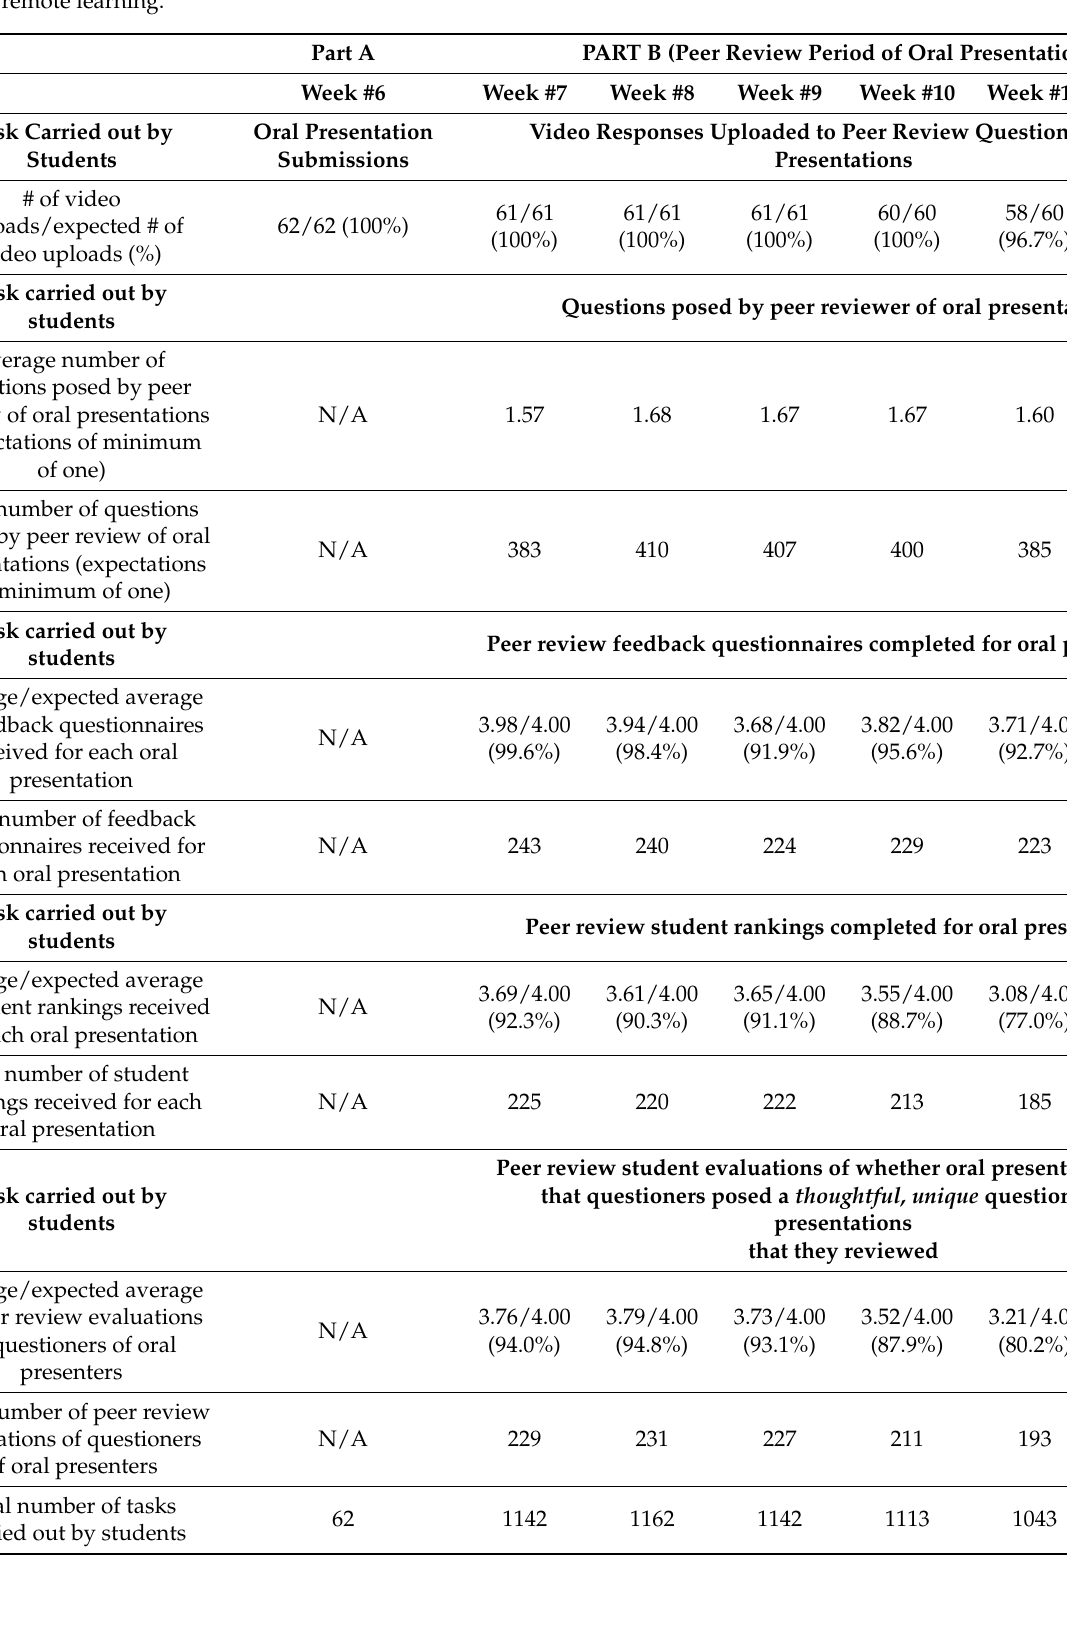
Table 1. Assessment of student engagement in 400 level oral presentation and discussion course carried out asynchronously by remote